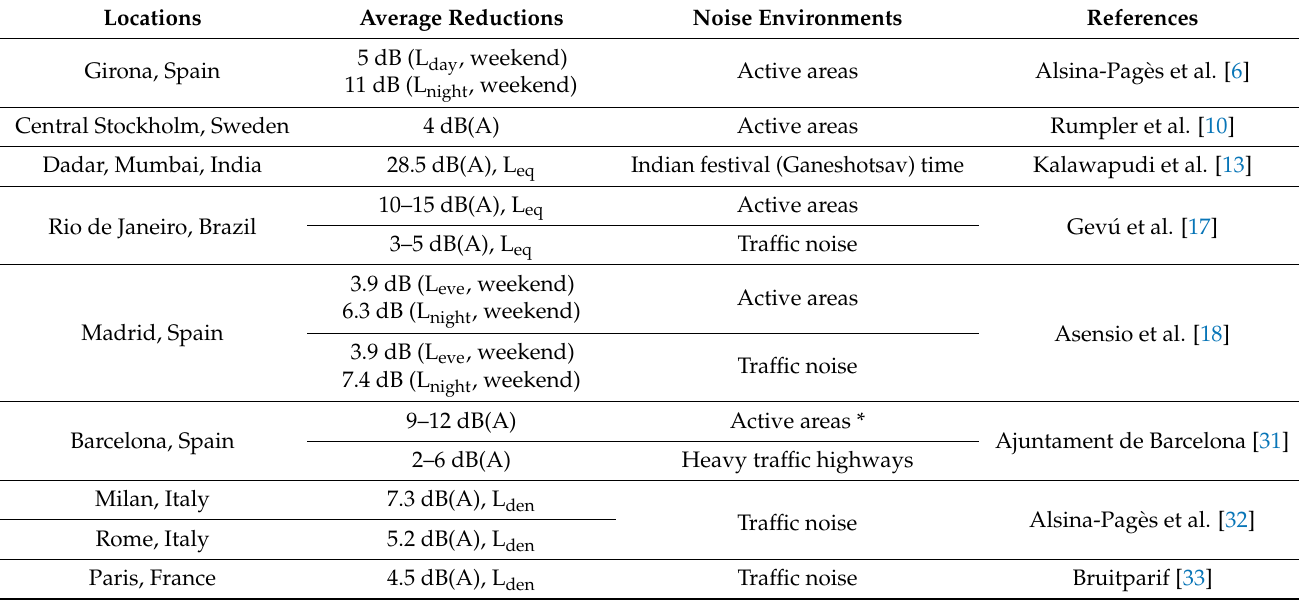
Table 1. Summarized data for reduction in average sound levels at various places during the COVID-19 pandemic.